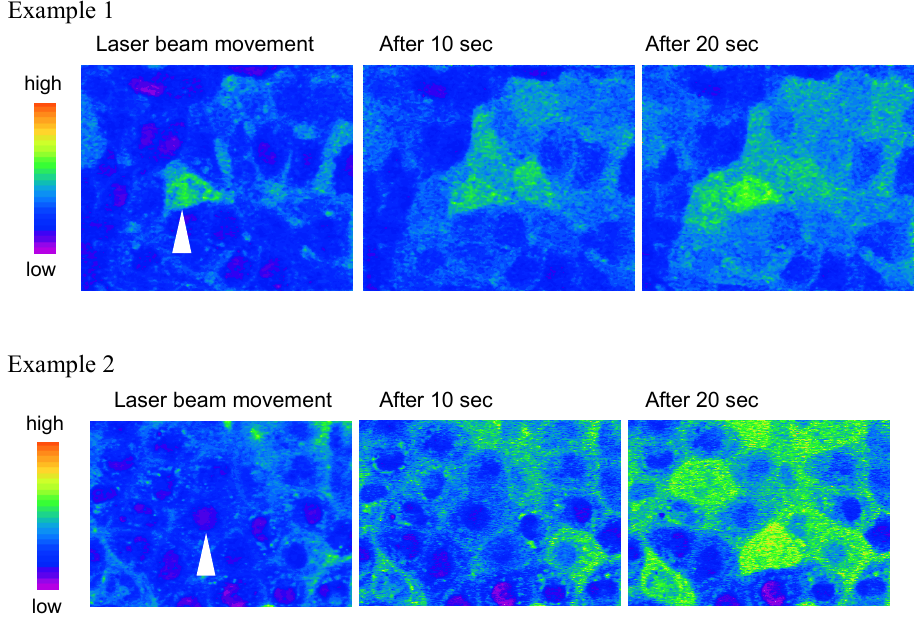
Fig. 6 Examples of the propagation of the intracellular Ca 2+ from stimulated EC to surrounding ECs as indicated with pseudo-color images of Ca 2+ concentration. Arrow heads indicate stimulated